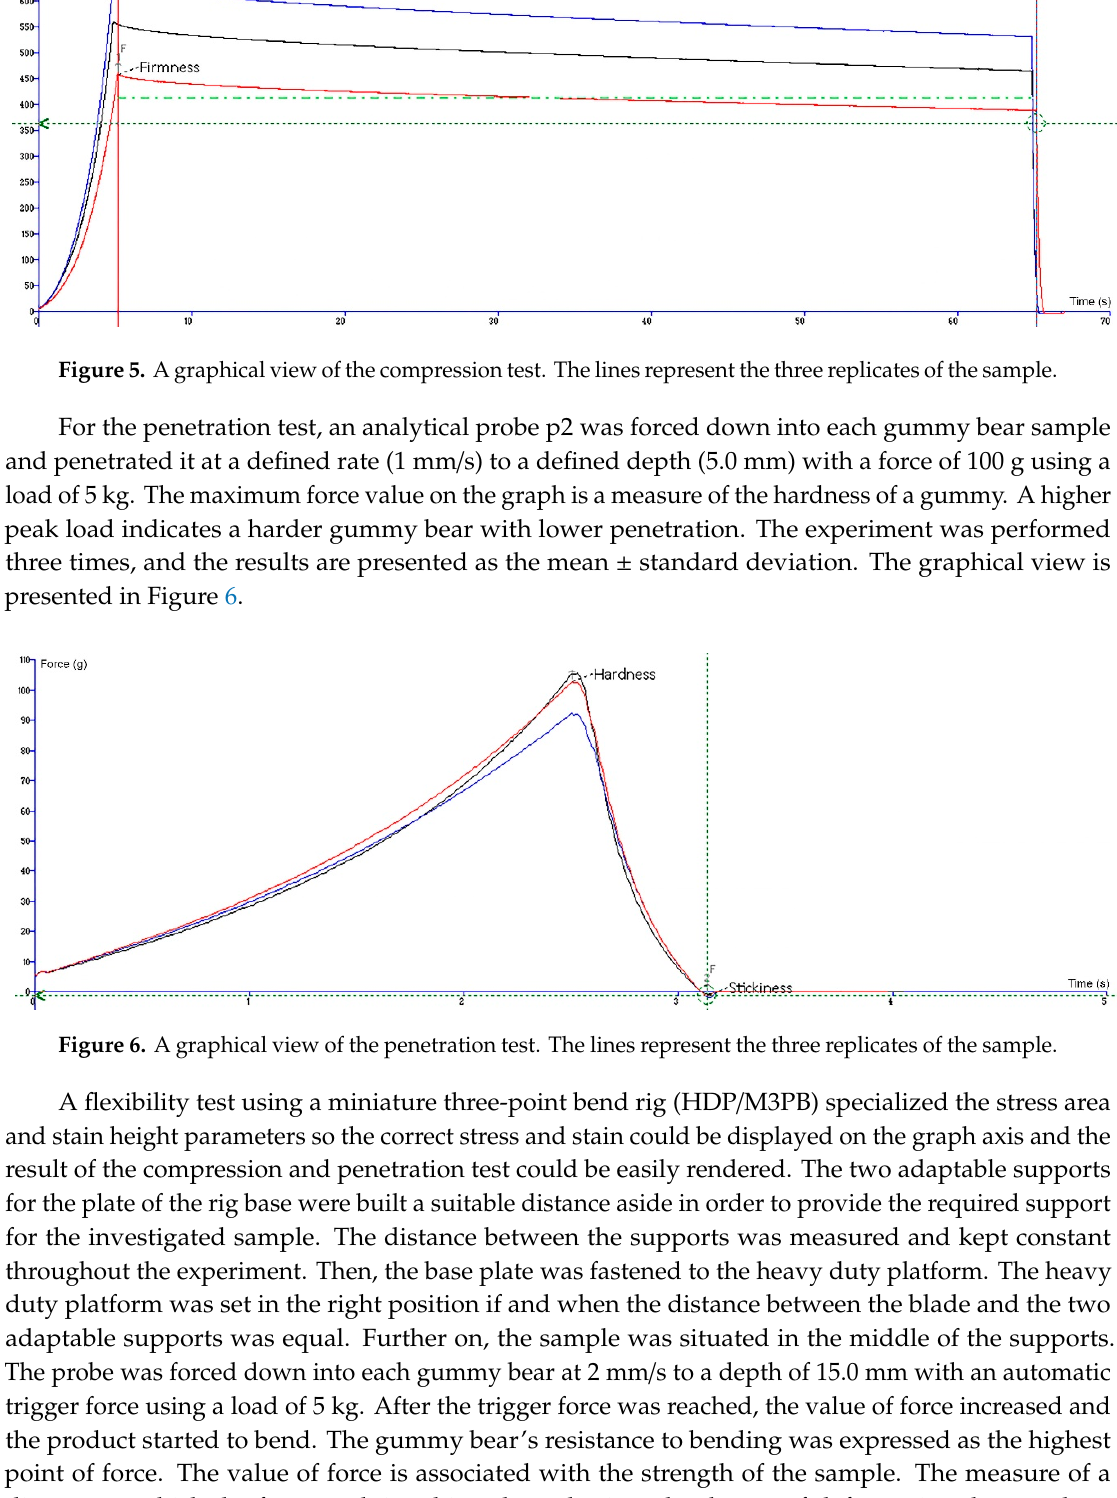
Figure 7. A graphical view of the flexibility test. The lines represent the three replicates of the sample. 3.6. The Organoleptic Properties of Gummy Bears Evaluation In Vivo The organoleptic properties evaluation was conducted according to the protocol of the biomedical study “The chewable dosage form: formulation and quality assessment” (BEC-FF-21) issued by the Lithuanian Bioethics Committee. The trial was carried out in accordance with the Declaration of Helsinki and International Ethical Guidelines for Biomedical Research Involving Human Subjects [51]. The choice of the test methods and search of volunteers were in accordance with ethical guidelines as well. The inclusion criteria were healthy volunteers, speaking and